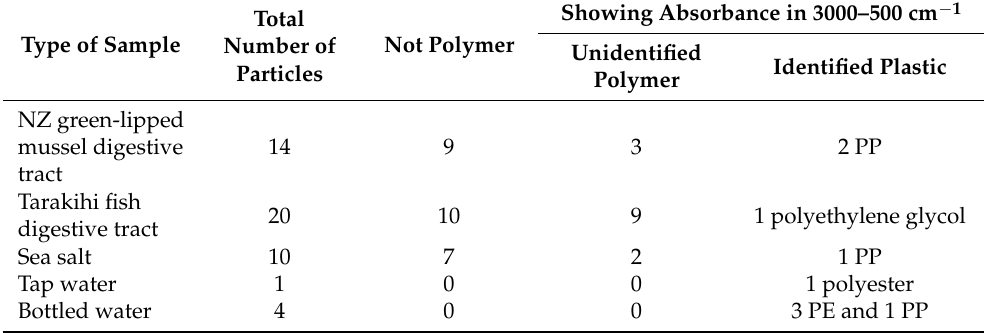
Figure 11. FTIR spectrum of a particle collected from bottled water identified as polyethylene. Table 1. The number of particles (fragments and beads) found in each sample and identified plastics using FTIR. Particles found in NZ green-lipped mussels, tarakihi fish, and sea salt were normalized per 100 g of sample. Particles found in tap water and bottled water were normalized per liter of